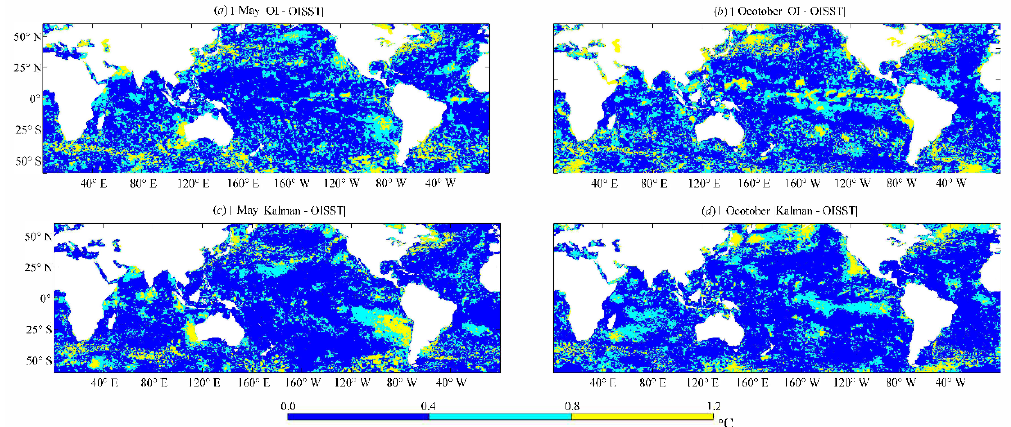
Figure 12. Difference distributions of the OI results ( a , c ) and Kalman results ( b , d ) with the OISST products from 1 May and 1 October 2016 respectively.